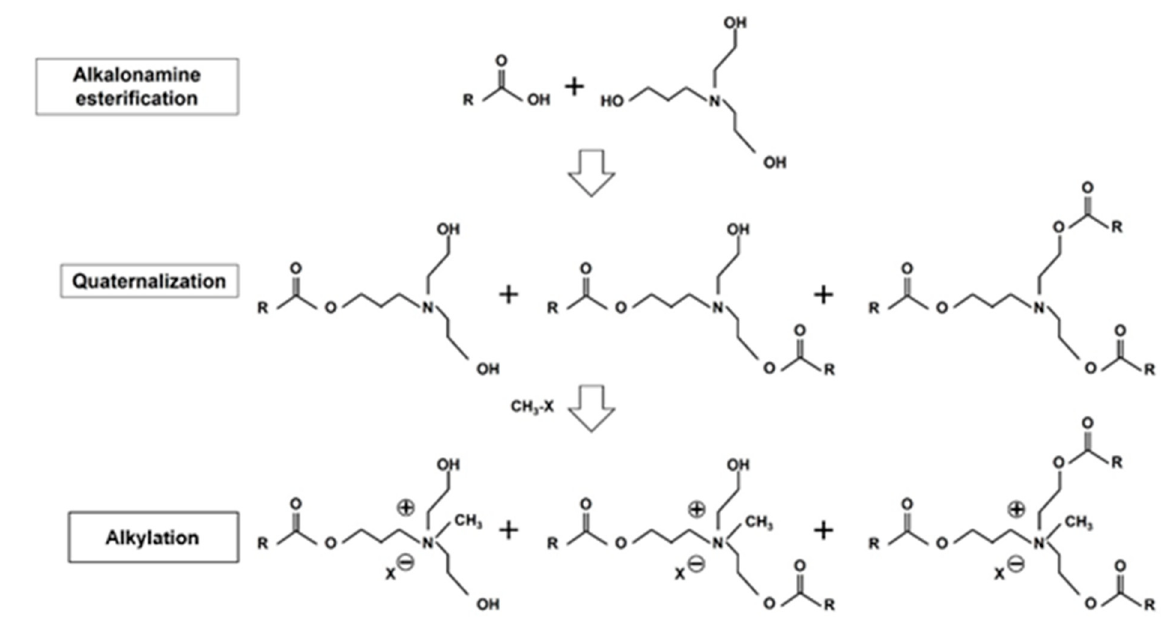
Figure 2. Production process of fabric softeners.